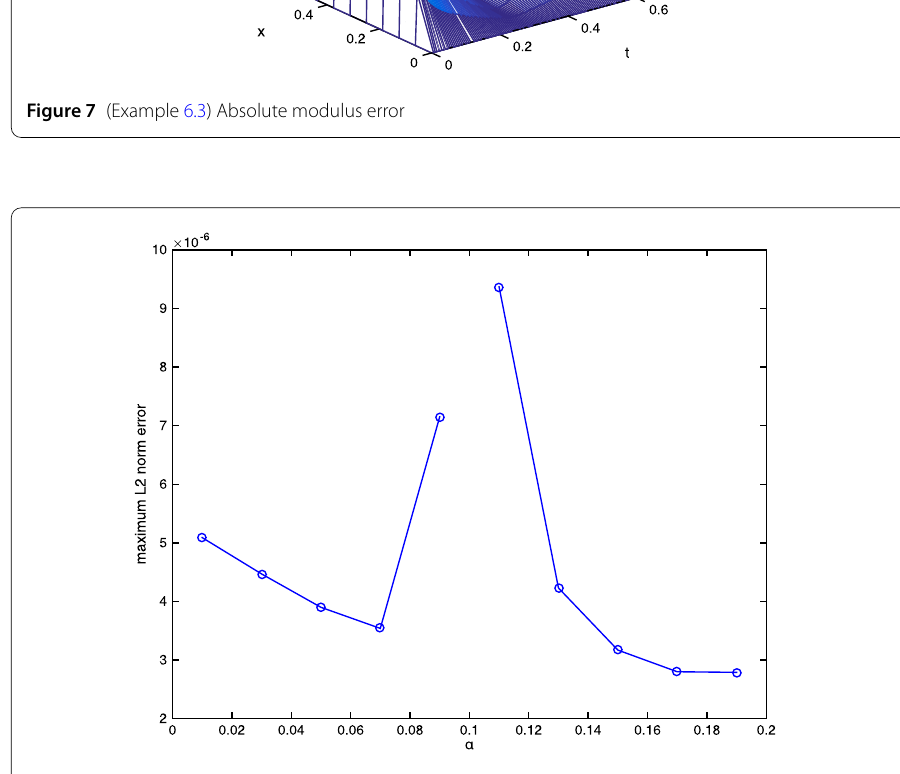
Figure 8 (Example 6.3) Influence of α on the error E 2 ( h , τ